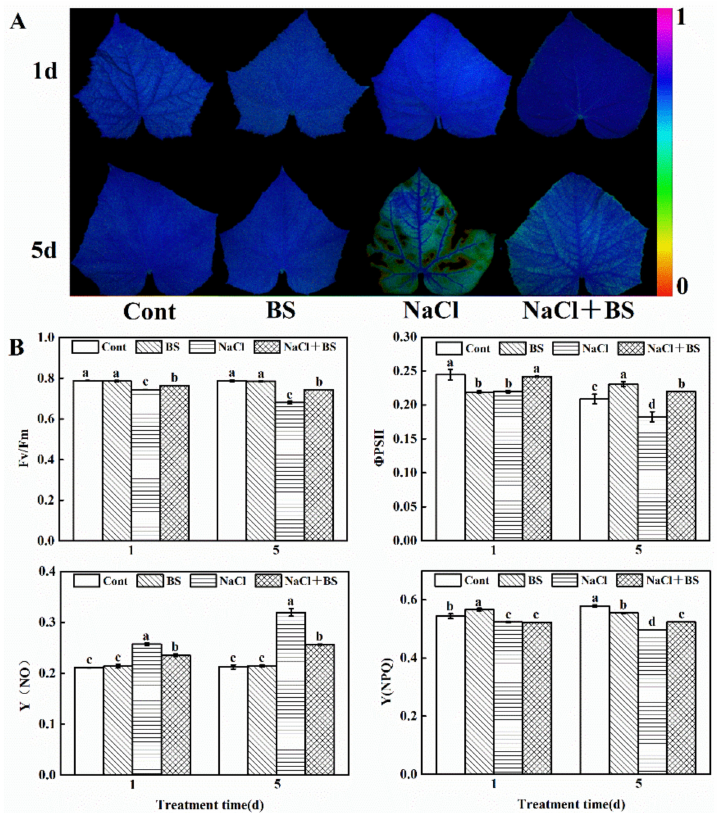
Figure 5. Effects of B. cereus on chlorophyll fluorescence imaging ( A ) and chlorophyll fluorescence parameters ( B ) of cucumber seedlings under salt stress. Bars represent standard errors. Different letters indicate a significant difference in the same parameter between treatments at p <